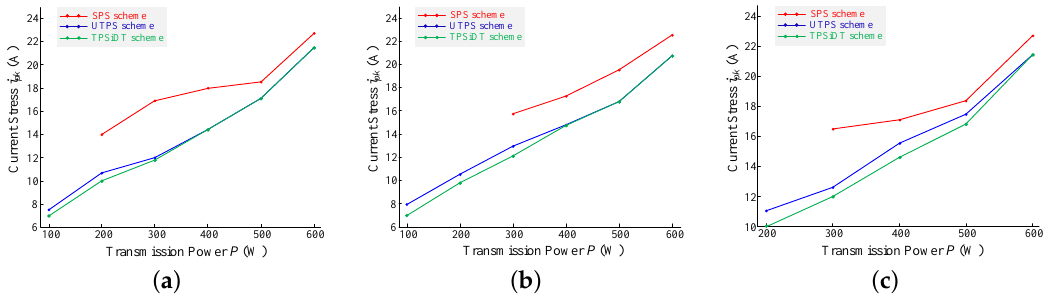
Figure 22. Current stress curves versus the transmission power P : ( a ) M min = 0.04; and ( b ) M min = 0.1; ( c ) M min = 0.15.